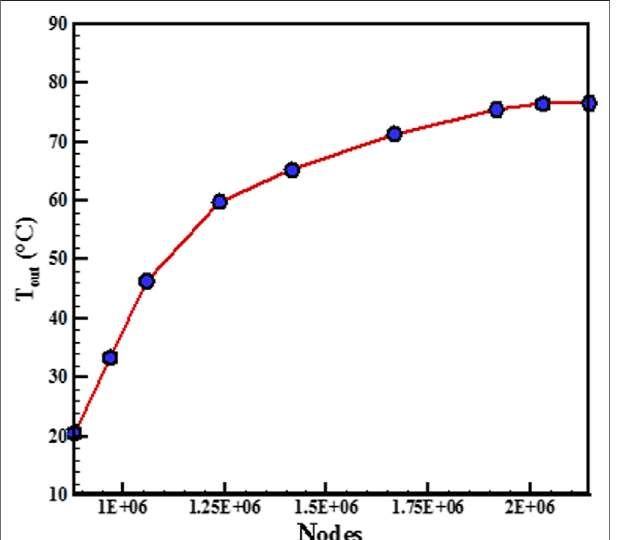
FIGURE 3 | The outcomes of the present study compared with Sheikholeslami et al. (2016).